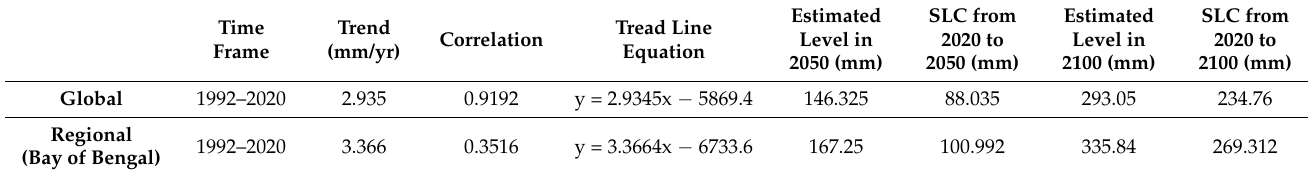
Table 5. The timeframe, sea level rise (SLR) trend, correlation, trend line equation, estimated level in 2050 and 2010, and SLR from 2020 to 2050 and 2100 for global and regional sea surface topography from 1992 to 2020. The regional data are based on the Bay of Bengal region. Data from altimeters from TOPEX/Poseidon and Jason-1, -2, -3 were averaged to create the historical record. Data